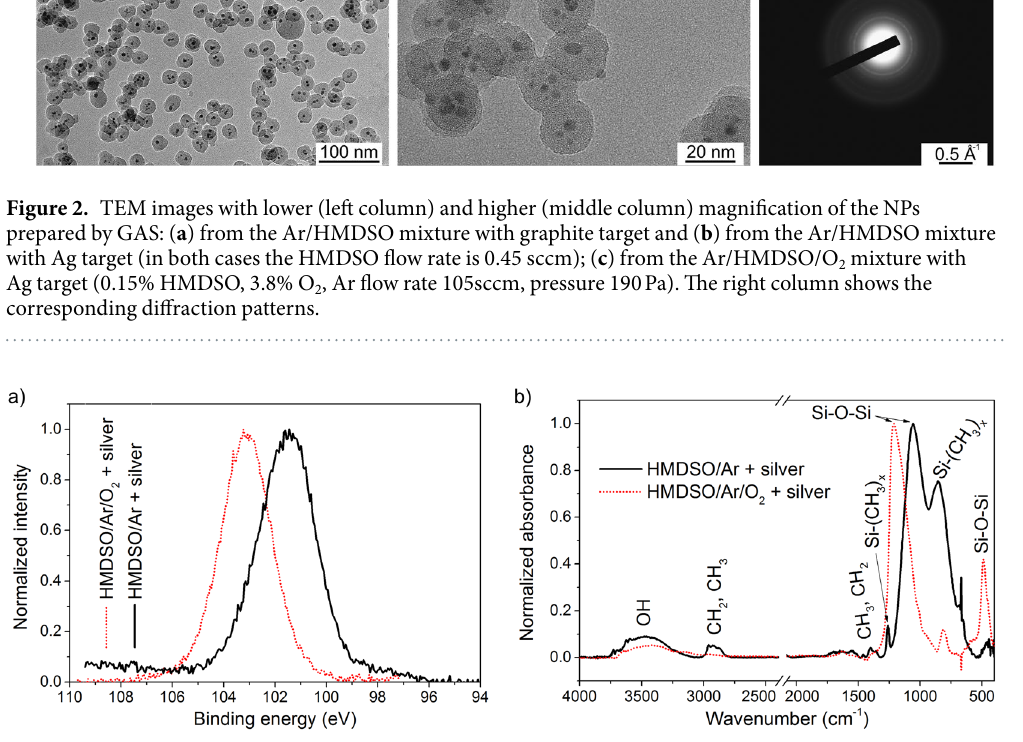
can be optimized to produce stoichiometric SiO 2 in the form of thin films or nanoparticles 29 . Figure 2c shows the result of such optimization performed in the GAS with the silver target. The addition of 4% of O 2 to the Ar/ HMDSO mixture leads to the fabrication of NPs with embedded multiple Ag inclusions with 5 nm average size. The XPS composition shows Ag 4%, C 3%, Si 32%, O 61%, which indicates that the shell consists of nearly sto- ichiometric SiO 2 . No diffraction pattern characteristic of crystalline silicon dioxide was detected, which points to an amorphous state of the shell. The formation of SiO 2 is also corroborated by high-resolution XPS, which shows a higher binding energy shift in the position of the Si 2p peak from 101.6 eV for the Ar/HMDSO mixture without O 2 to 103.1 eV for the mixture with O 2 (Fig. 3a). Furthermore, the FTIR-RAS spectra of both types of NPs also reveal the chemical changes from the organic to the predominantly inorganic SiO 2 character (Fig. 3b). The addition of O 2 leads to the disappearance of the bands associated with vibrations of the hydrocarbon and organosilicon groups (see, for example, CH x stretching at 2960–2870 cm − 1 and Si-(CH 3 ) x rocking at 850 cm − 1 ).